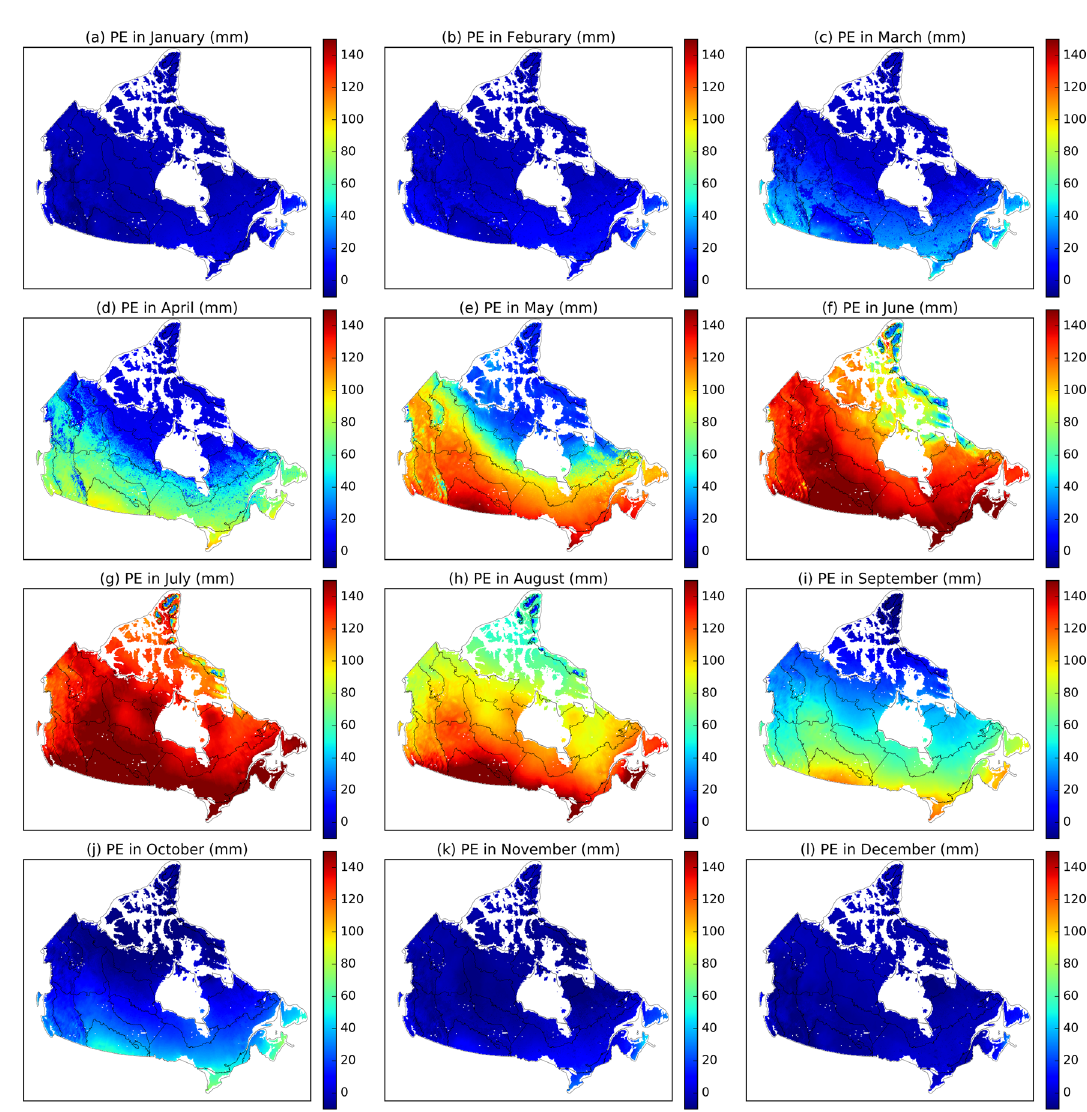
Figure 6. The spatial and seasonal variations in mean monthly potential evaporation (PE, mm) during 1979– 2016 in Canada (The black lines depict each ecozone’s spatial extent. The map was created using our own script in Anaconda Python 3.8 downloaded from https ://docs.anaco nda.com/anaco nda/insta